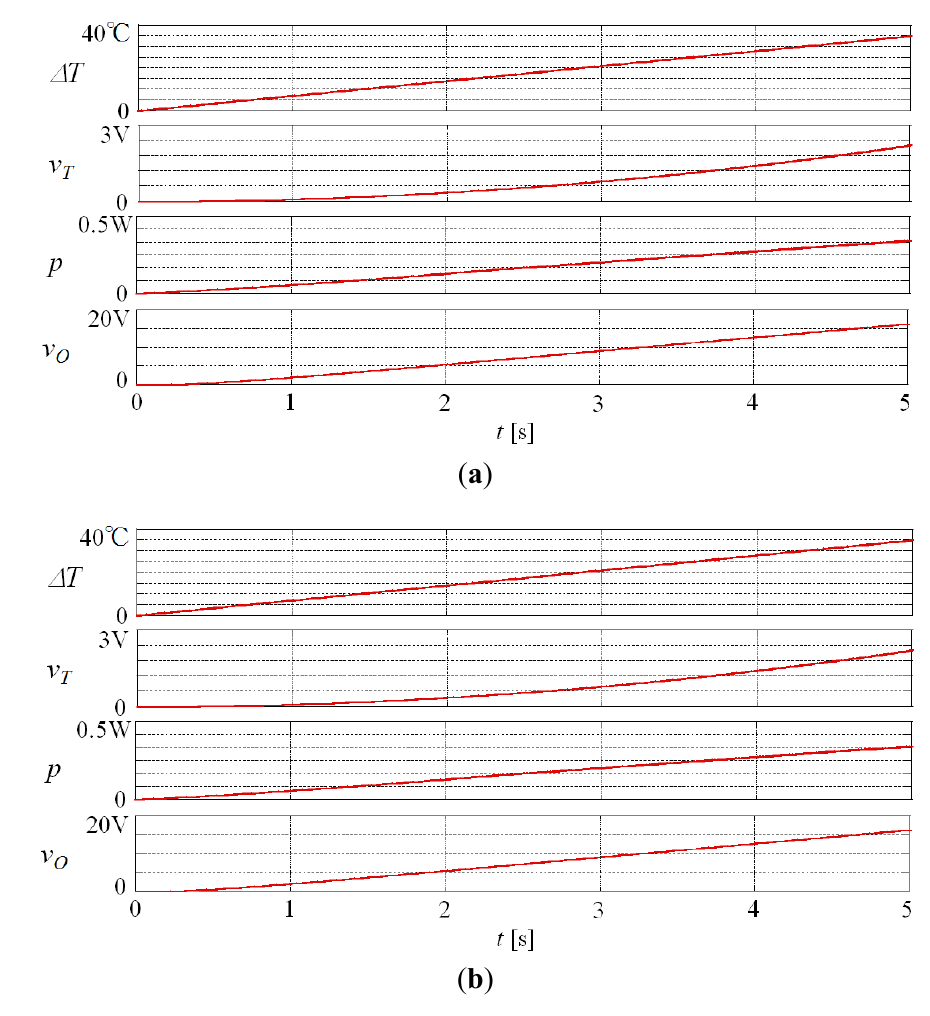
Figure 9. Simulation results in the case of the thermal difference fluctuation. ( a ) From 0 to 35 °C; ( b ) From 35 °C to 0.